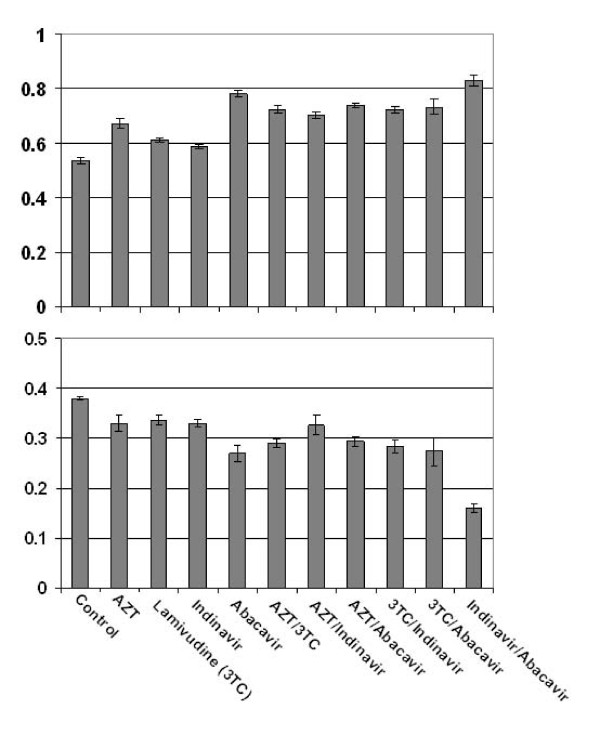
ART medications inhibit microglial phagocytosis of Aβ1-42 peptides. N9 microglia were treated with "aged" FITC-tagged Aβ 1-42 (300 nM) in complete medium for 120 min in the presence of 10 μM concentrations of antiretrovirals. Total FITC-Aβ1-42 peptides were analyzed by fluorescence from conditioned media (extracellular; top) and cell lysates (phagosomal/cell associated; bottom). Data are represented as the relative mean ± SEM fluorescence (n = 4 for each condition presented). When measuring extracellular FITC-tagged Aβ 1-42, one-way ANOVA followed by post hoc comparison showed significantly higher levels following all antiretroviral treatments, as compared to control (p < 0.05). When measuring cell associated FITC-tagged Aβ 1-42, one-way ANOVA followed by post hoc comparison showed significantly lower levels following Indinavir, Abacavir, AZT/3TC, AZT/Abacavir, 3TC/Indinavir, and Indinavir/Abacavir, as compared to control (p < 0.05).